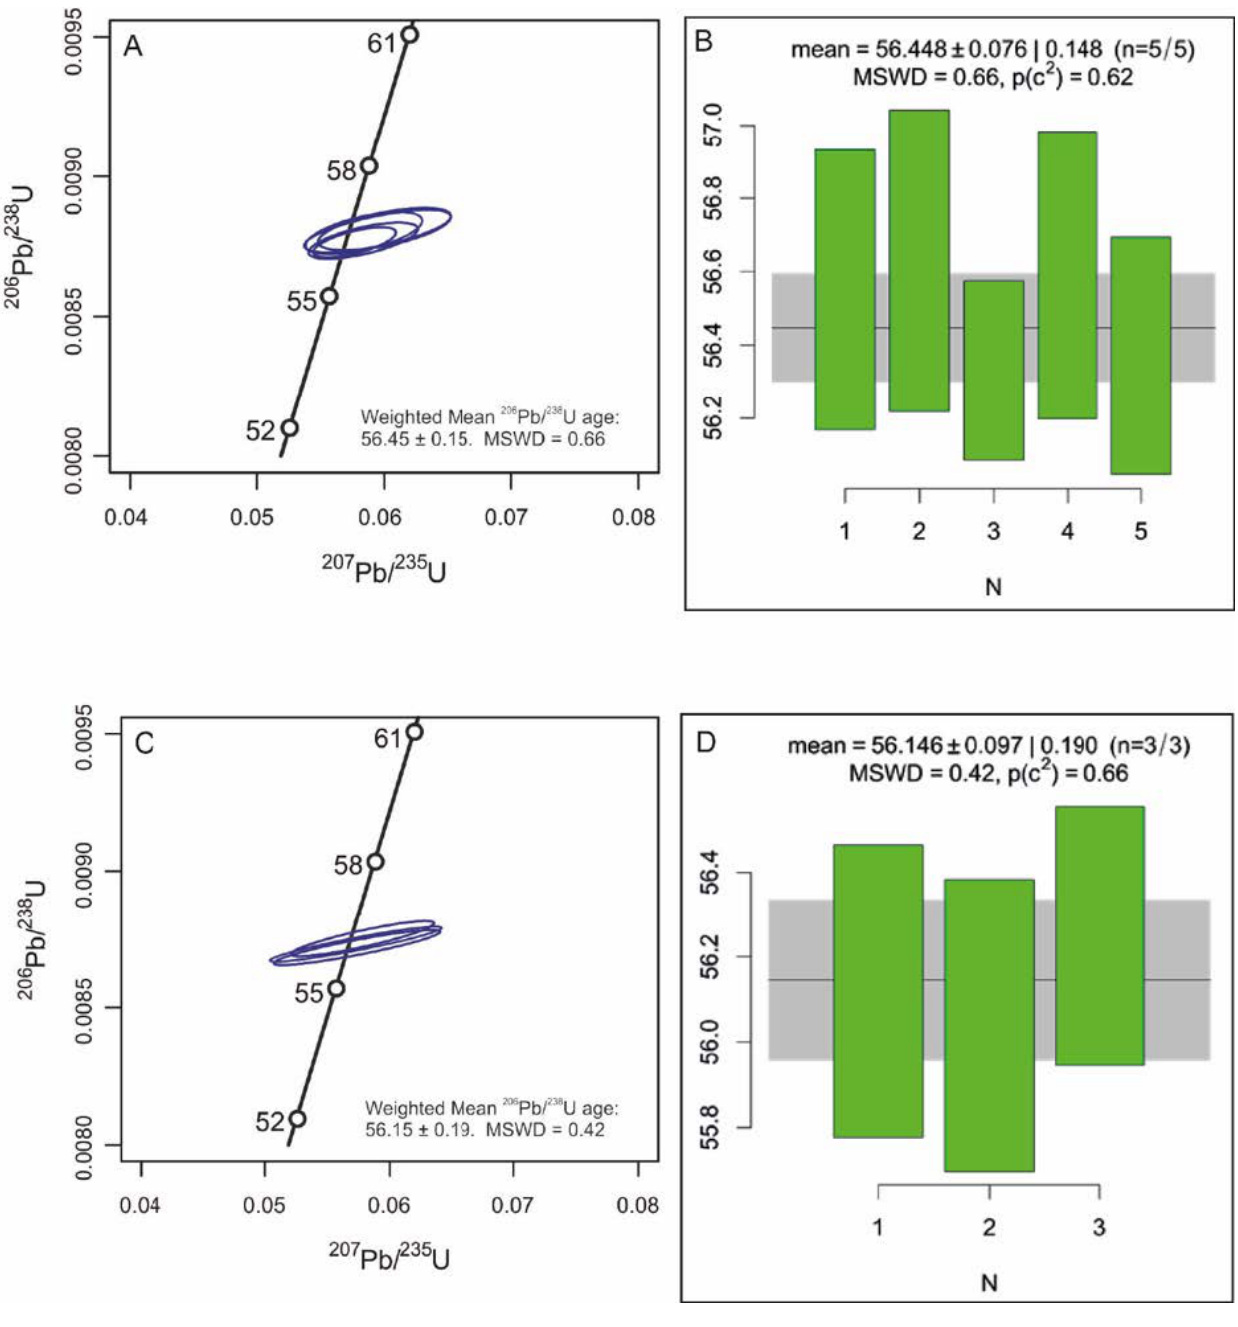
Figure 17: Results of U-Pb dating of zircons using chemical abrasion isotope dilution thermal ionisation mass spectrometry (for full details of methodology refer to Supplementary Material 1): [A] 95 % confidence ellipses for zircon ages within granitic inclusions on Ben Suardal (NG 63191 20477). [B] Weighted average dates for zircons in [A] (NG 63191 20477). [C] 95 % confidence ellipses for zircon ages from Stage 3 KVF mLTi at Allt nan Suidheachan (NG: 59618 20783) see (Figure 3, log 16, 445m height, Figure S1, Supplementary Tables 2–6: Supplementary Material 1) [D] Weighted average dates of zircons in [C] (NG: 59618 20783). NNW-trending faults, and downthrown to the ENE (Figure